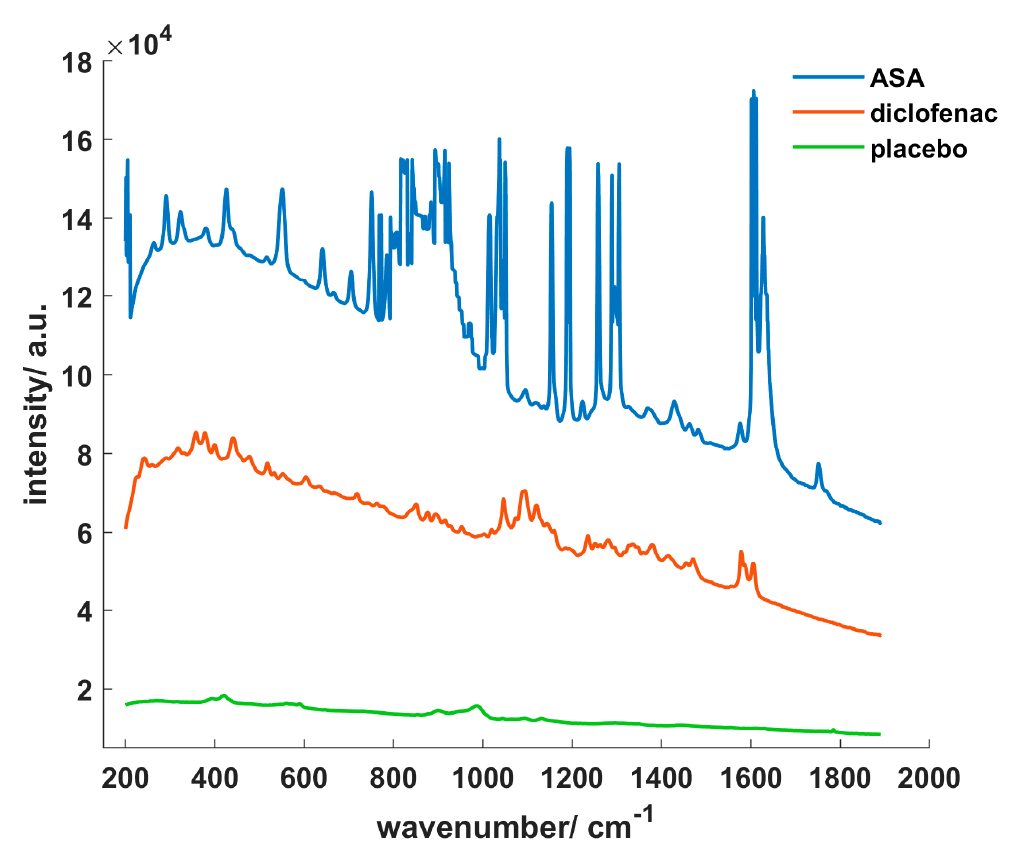
Figure 2. Raman spectra of acetylsalicylic acid (ASA), diclofenac and placebo cores.